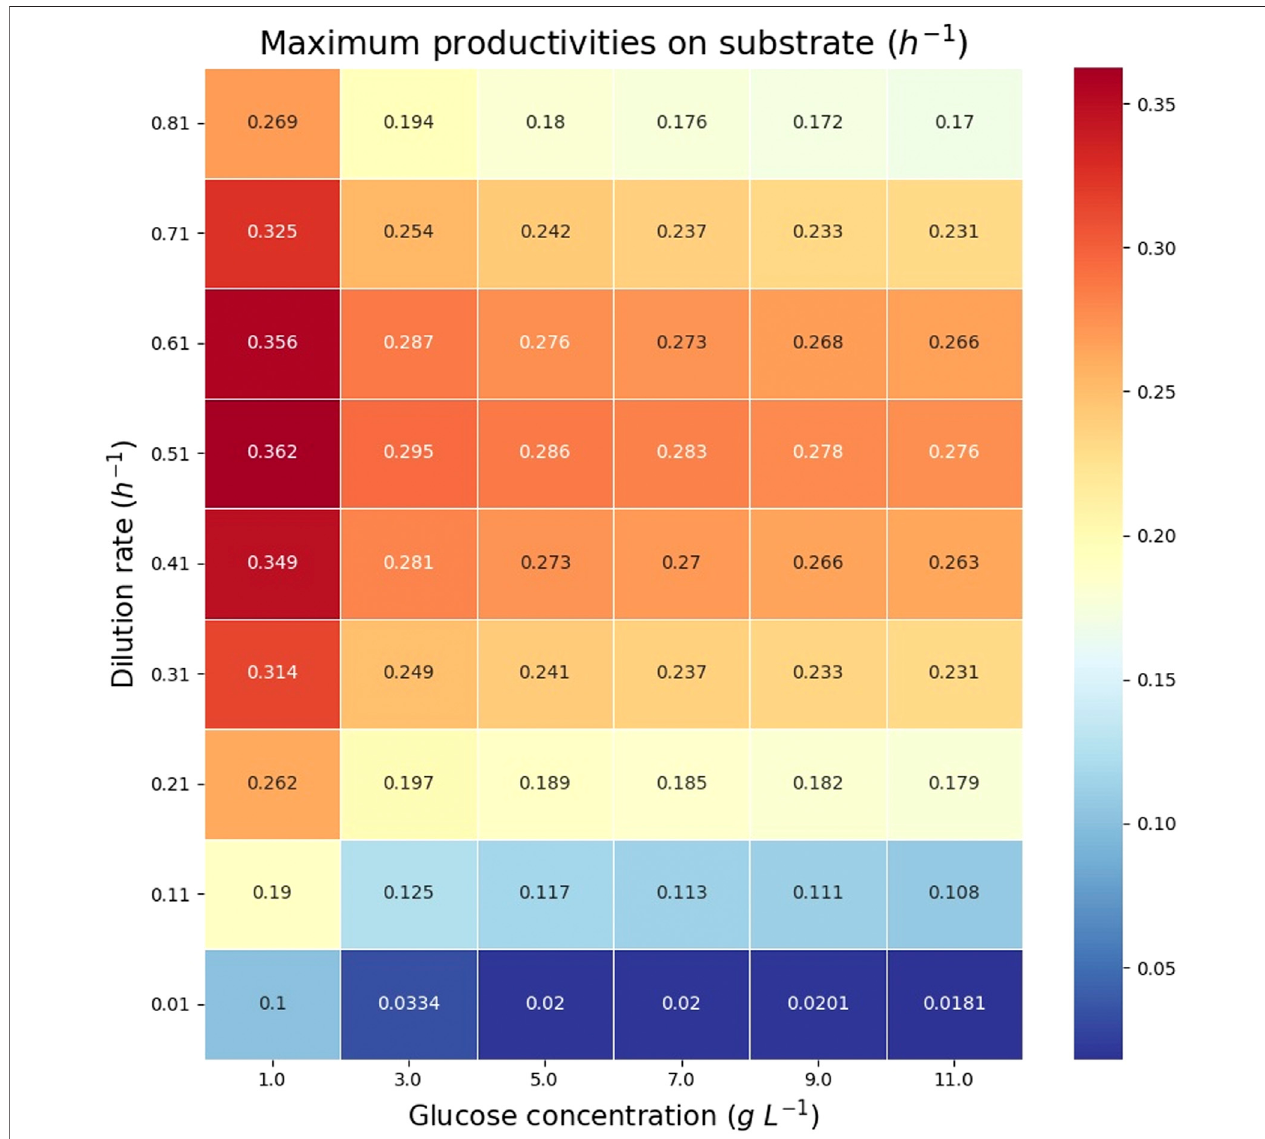
FIGURE 9 | Heatmap reporting the maximum productivities on substrate ( PS ) for each glucose concentration and dilution rate.